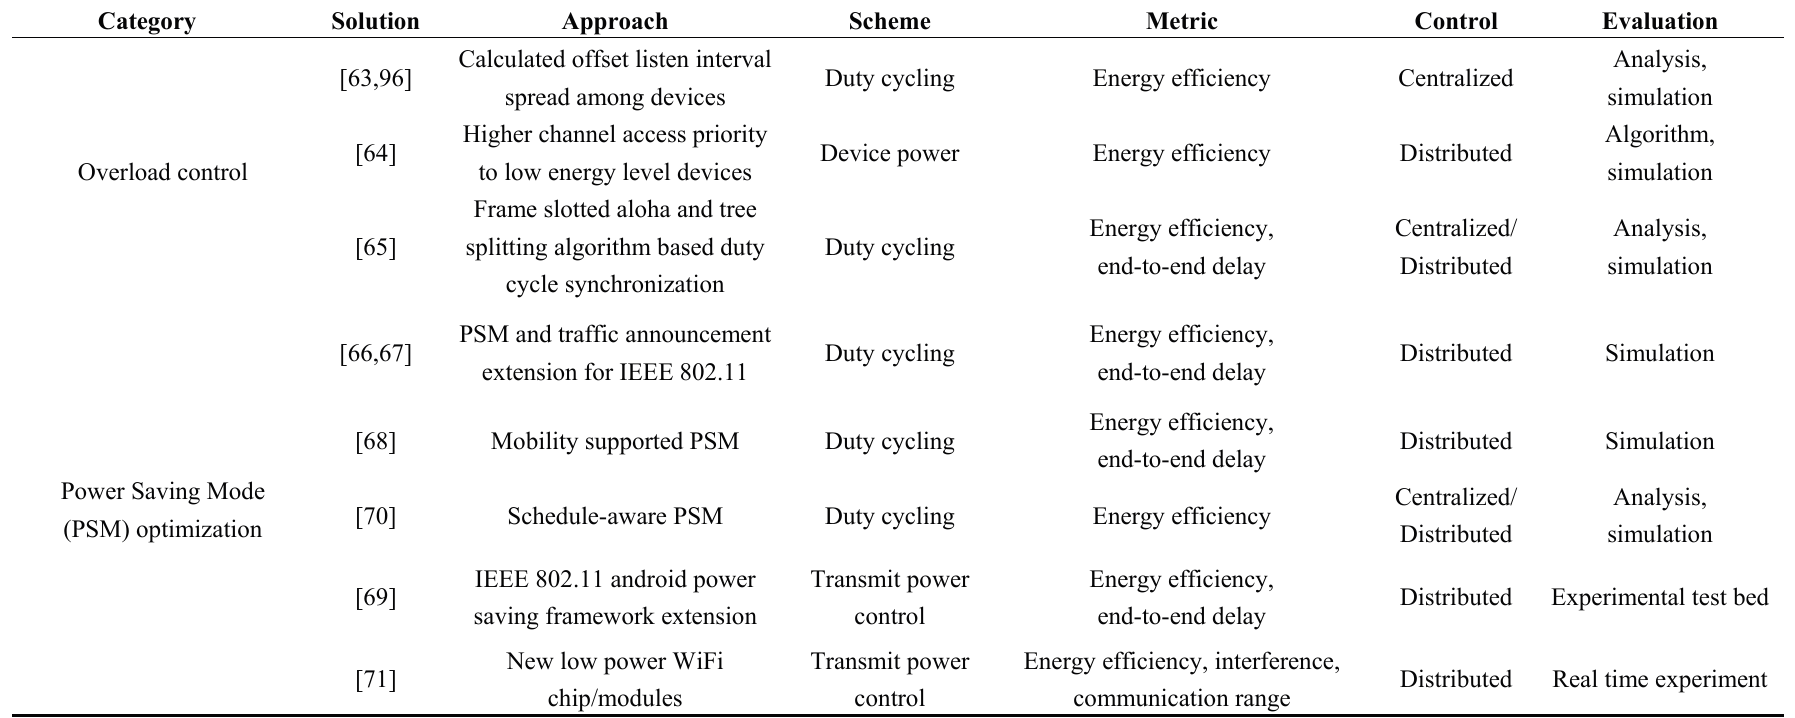
Table 2. Energy conserving solutions for wireless local area network-based